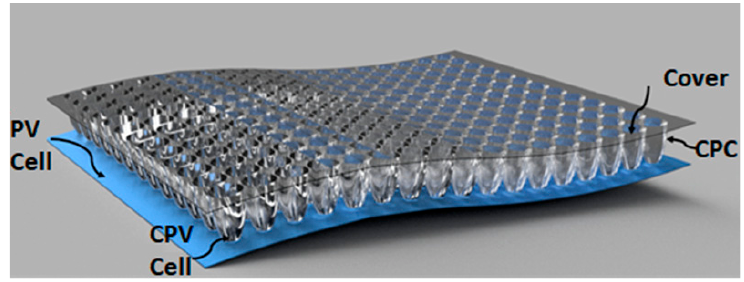
Figure 10. The flexible structure of the static CPV module for vehicle applications.